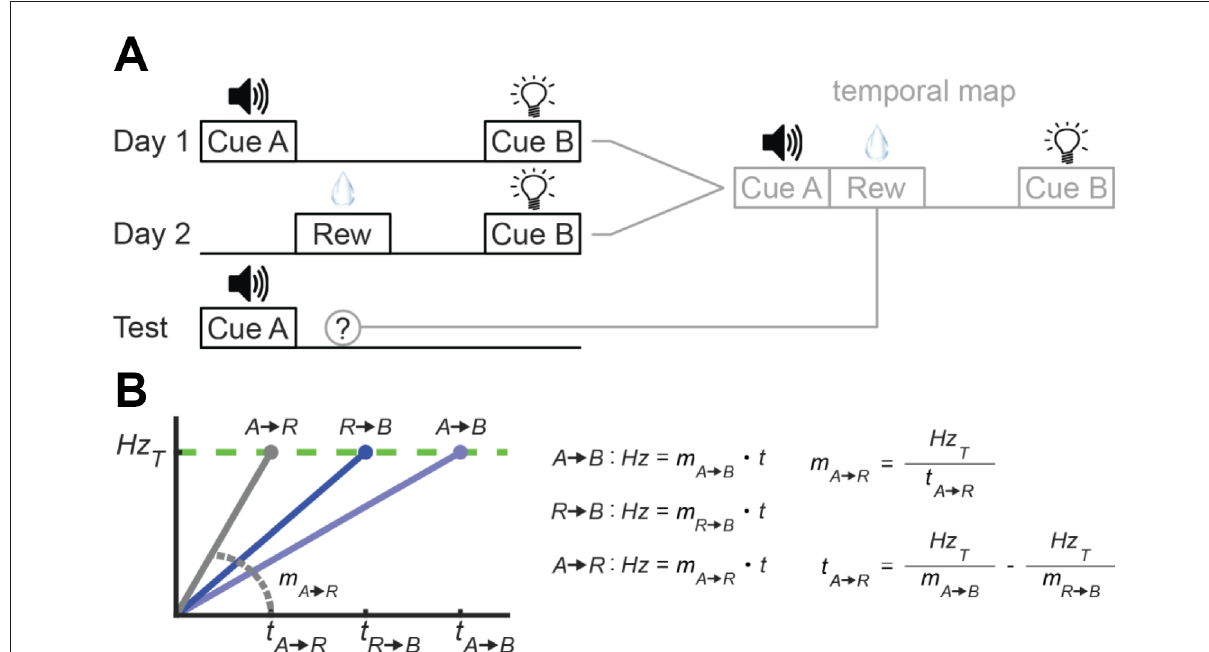
FIGURE11 Temporal maps and absolute time. (A) Temporal map concept and design. Left: Task-structure across the three phases. Right: Hypothetical integration of phases 1 and 2 into a temporal map that is then used during testing. (B) Converting between relative and absolute time with a ramping model during a temporal map